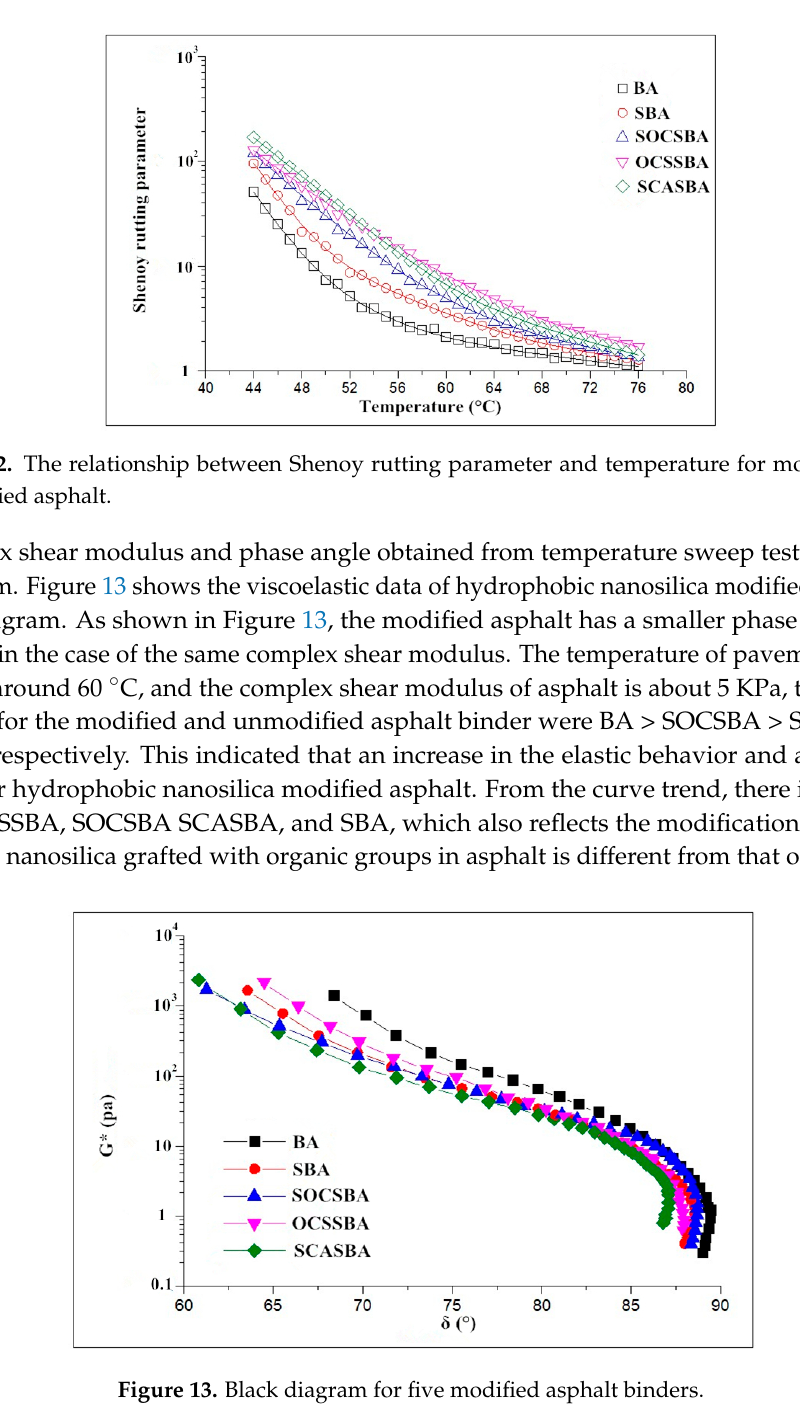
Figure 13. Black diagram for five modified asphalt binders.